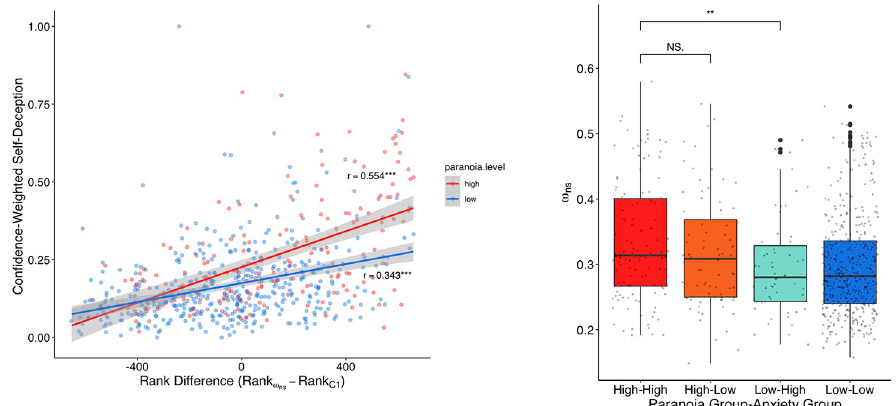
Fig 5. A , Difference between the relative perceived choice reliability (rank of ω ns ) and relative objective classification performance (rank of C1 accuracy) is correlated with confidence-weighted self-deception. A higher ω ns represents a lower perceived choice reliability (analogously, a higher perceived choice unreliability), so individuals scoring high on this rank difference have high perceived unreliability and low ability. This relationship is significantly stronger in the high paranoia group compared to the low paranoia group. B , High paranoia is responsible for elevated ω ns independent of anxiety. The high paranoia high anxiety group showed similar values of ω ns to the high paranoia low anxiety group, while the low paranoia high anxiety group had a significantly decreased ω ns